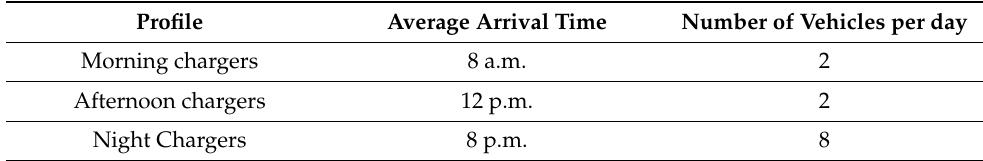
Table 4. Current charging profiles at